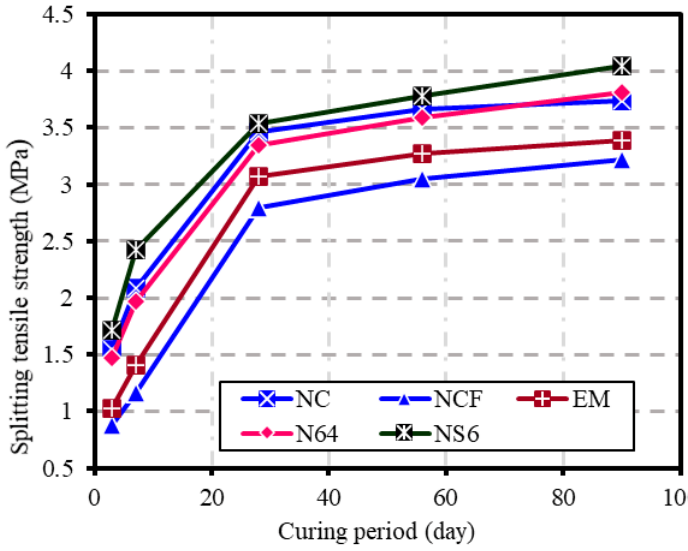
Figure 10. Variation of splitting tensile strength against curing